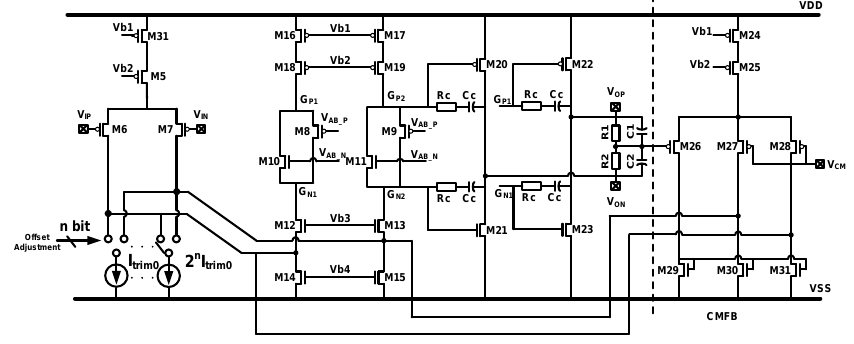
Figure 12. The circuit diagram of the front-end